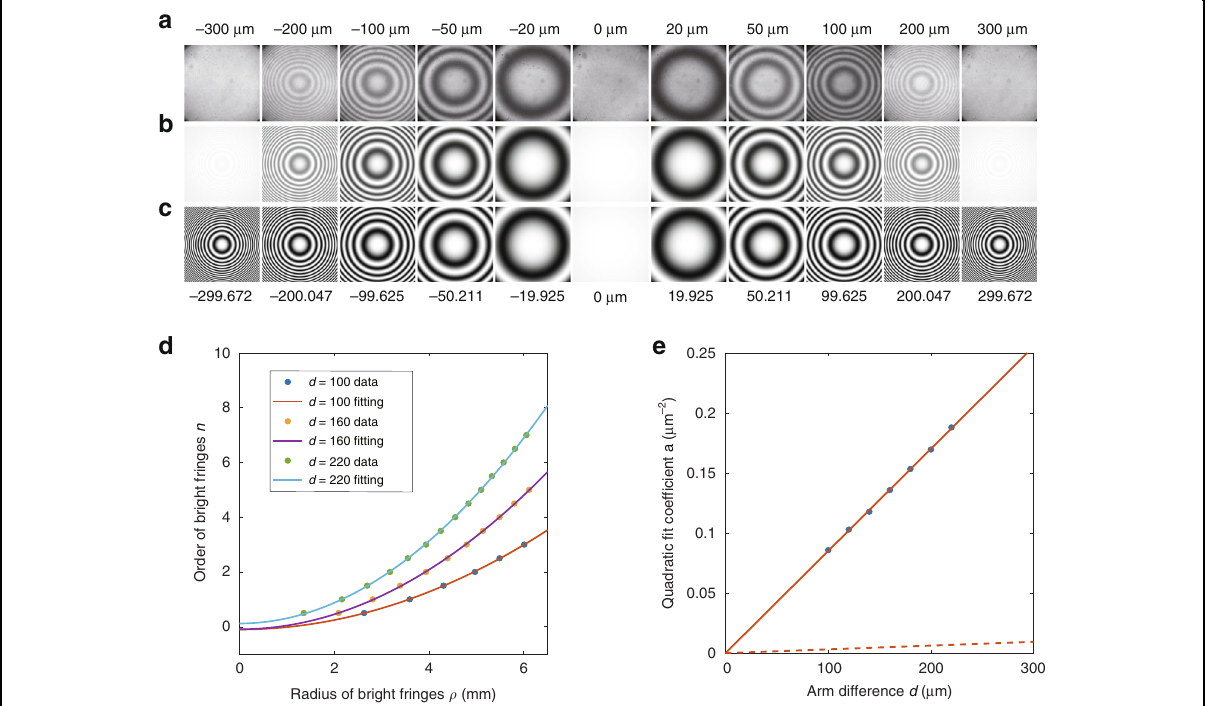
Fig. 3 Results. a Experimental results. b Simulation results. c Predictions using Eq. (3). d The evaluated radial distance on camera of the minima and maxima for d = 100 μ m, 160 μ m, 220 μ m. The integer and half-integer orders correspond to maxima and minima, respectively. e The quadratic coef fi cients a are obtained by fi tting the data of d = 100, 120, 140, 160, 180, 200, 220, 220 μ m. The data (blue spots) are fi tted by a linear function (red line). The a e - d relation (dashed line) of the equal-inclination interference is shown for